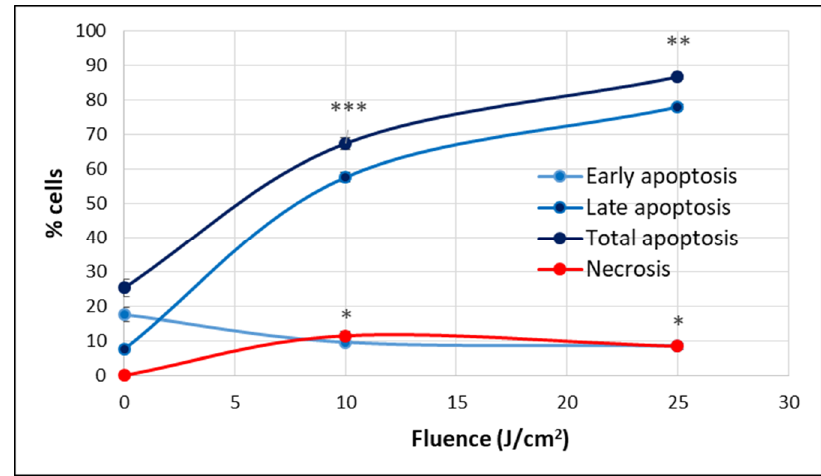
Figure 8. The percentage of apoptotic and necrotic HT29 cells in samples exposed to PDT (10 J/cm 2 and 25 J/cm 2 , 50 mW/cm 2 ) and in non-treated controls. Apoptosis and necrosis were assessed by flow cytometry using FITC-annexin V and propidium iodide at 24 h post-PDT. Results are presented as percentage (mean ± SEM) of cells in triplicate samples, regarding early, late and total apoptosis, as well as necrosis. Comparison between treated and non-treated samples was performed using Student’s t -test considering unequal variances. * p < 0.05, ** p < 0.01, *** p < 0.001.